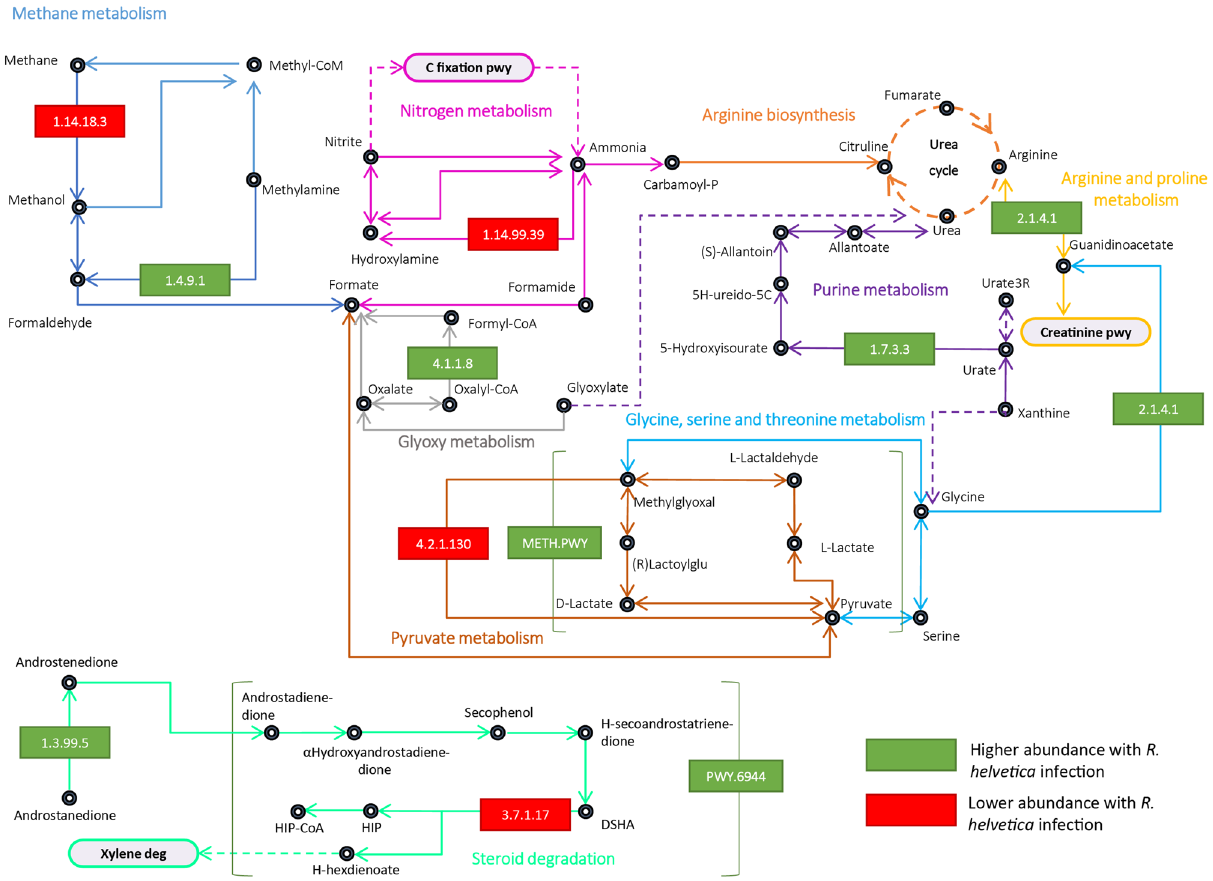
Figure 6. Partial reconstruction of microbial metabolic pathways in the tick microbiome. Partial reconstruction of methane, nitrogen, arginine and proline, glycine, serine and threonine, glyoxylate and dicarboxylate, purine, pyruvate, glycan biosynthesis and steroid degradation metabolic pathways is displayed. Only metabolic enzymes and pathways with significant differences in relative abundances ( p < 0.05) between R. helvetica- positive and pathogen-free I. ricinus ticks are represented. KEGG annotation were included in this analysis. Continuous lines represent direct reactions catalyzed by enzymes. Dashed lines represent reconstruct reactions with shortcuts. Oval boxes represent pathway reconstruction based in KEGG. Enzymes with significant abundance difference are represented in a green rectangle, if they have a higher abundance, and in red, if they have a lower abundance, in R. helvetica -positive compared to pathogen-free samples. Pathway with a significant difference of abundance between pathogen-free and R. helvetica- positive samples are represented in brackets, in green or in red if the abundance is higher or lower with R. helvetica presence. C fixation pwy, Carbon fixation pathways in prokaryotes; Carbamoyl-P, Carbamoyl phosphate; Meth.pwy, Methgyut.pwy; Creatinine pwy, Creatinine pathway; Glyoxy meth, Glyoxylate and dicarboxylate metabolism; Xylene deg, Xylene degradation; G8 Glycane G00008; G9, Glycane G00009; D-diphospate, Dolichyl diphosphate; Protein asp, Protein asparagine; Androstadienedione, Androsta-1,4-diene-3,17-dione; αHydroxyandrostadienedione, 9 alpha-Hydroxyandrosta- 1,4-diene-3,17-dione; H-secoandrostatrienedione,